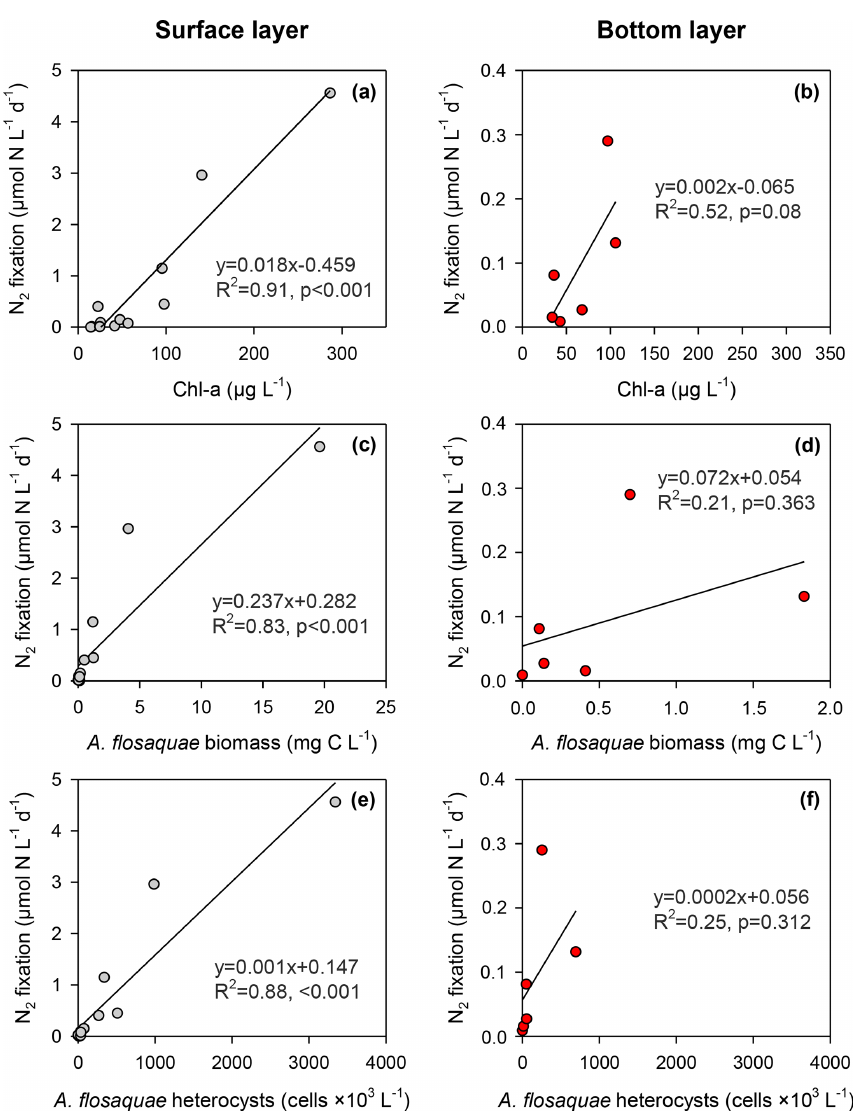
Figure 7. Relationships between N 2 fixation and in situ measured chlorophyll a (a, b) , A. flos-aquae biomass (c, d) and their heterocysts (e, f) in surface (northern and central sites, left panels) and bottom (central site, right panels) layers of the Curonian Lagoon during April– September